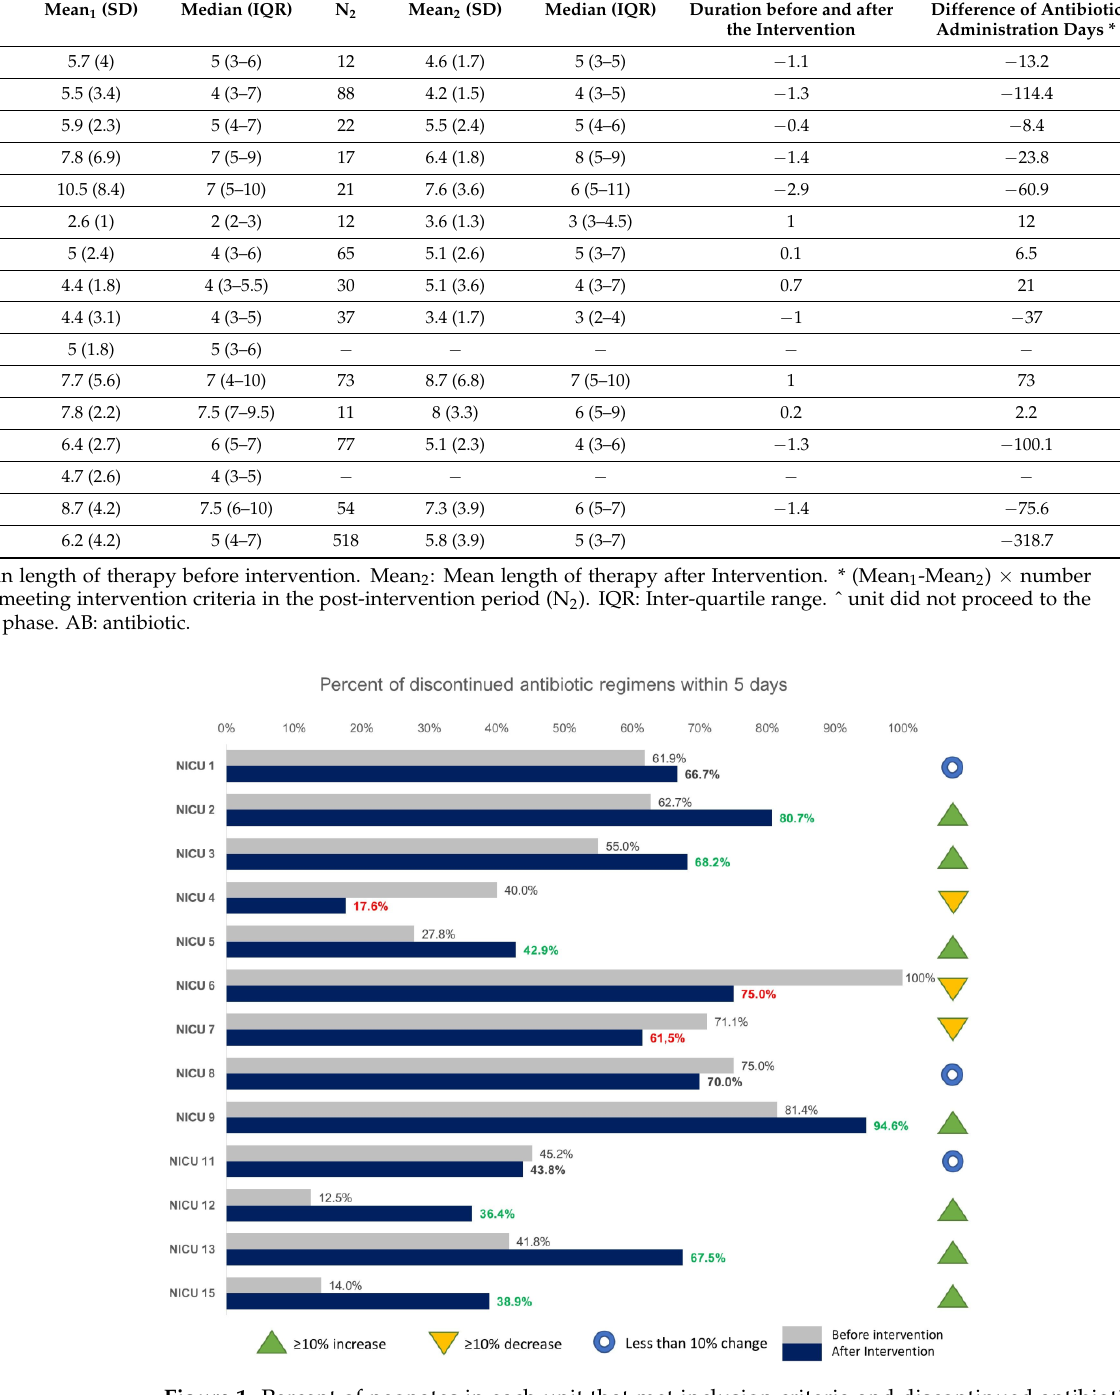
Table 2. Length of therapy before and after the intervention of neonates that met the inclusion criteria and given empiric treatment for possible early-onset sepsis.